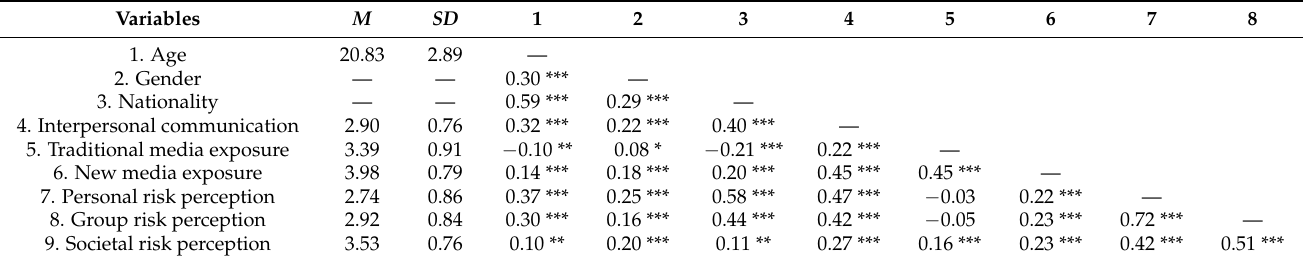
Table 1. Means, standard deviations, and correlations between